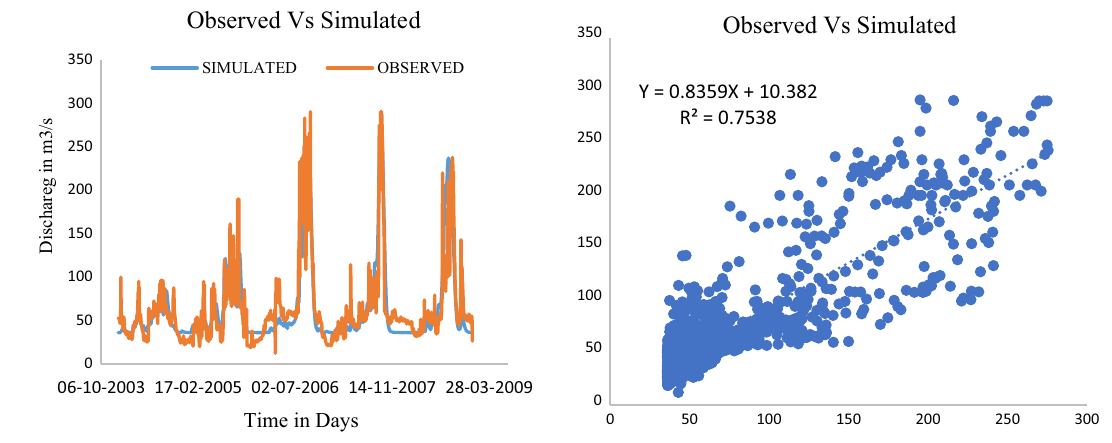
Fig. 4 Simulated versus observed flow data for initial and constant loss method after calibration